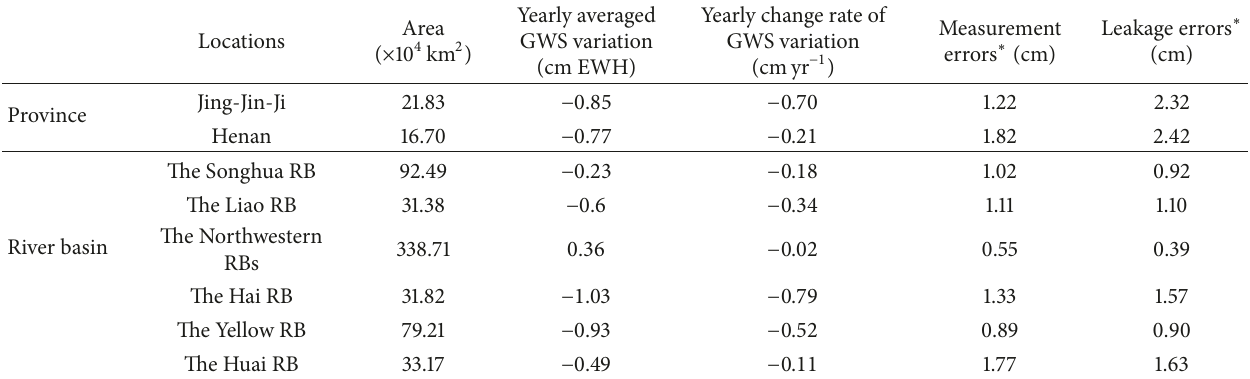
Table 3: TWS errors estimation in river basins and representative provinces from 2003 to 2012. Area Measurement Locations